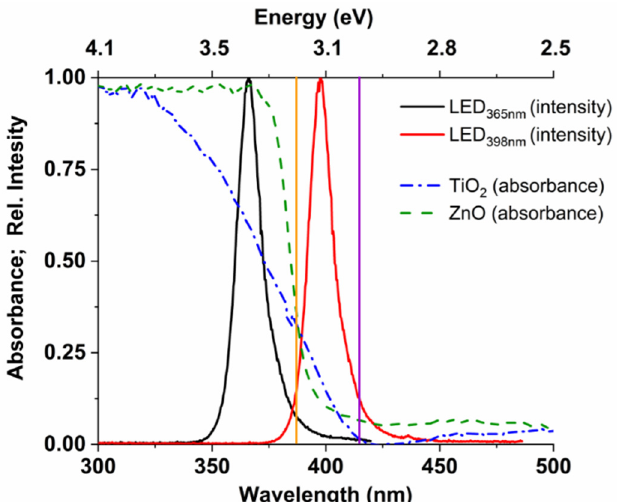
Figure 2. The emission spectra of the LEDs (black and red line), and the absorption spectra of the TiO 2 and ZnO photocatalysts (blue and green interrupted line). The bandgap of the ZnO and TiO 2 anatase (3.2 eV) with a vertical orange line, and the bandgap of TiO 2 rutile (3.0 eV) with a vertical purple line).